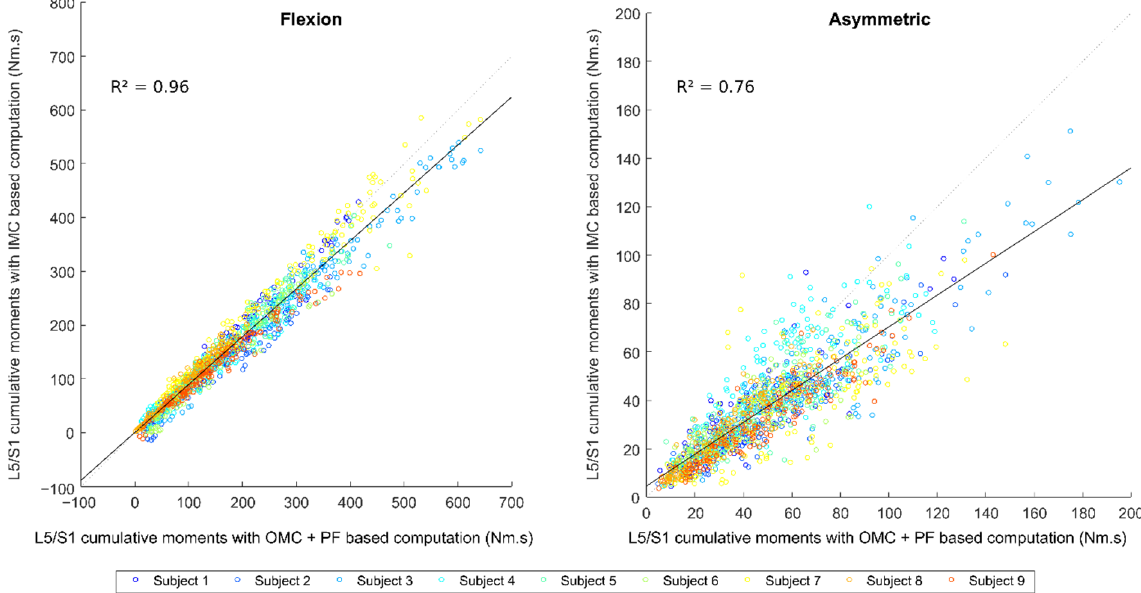
Figure 4. Correlation plot between OMC + PF-based and IMC-based computations of L5/S1 cumu- lative moments. Table 2. Bland–Altman bias (b), confidence interval (CI), as well as the coefficient of determination (R 2 ) and RMSE between OMC + PF-based and IMC-based computations for L5/S1 peak and cumu- lative moments.